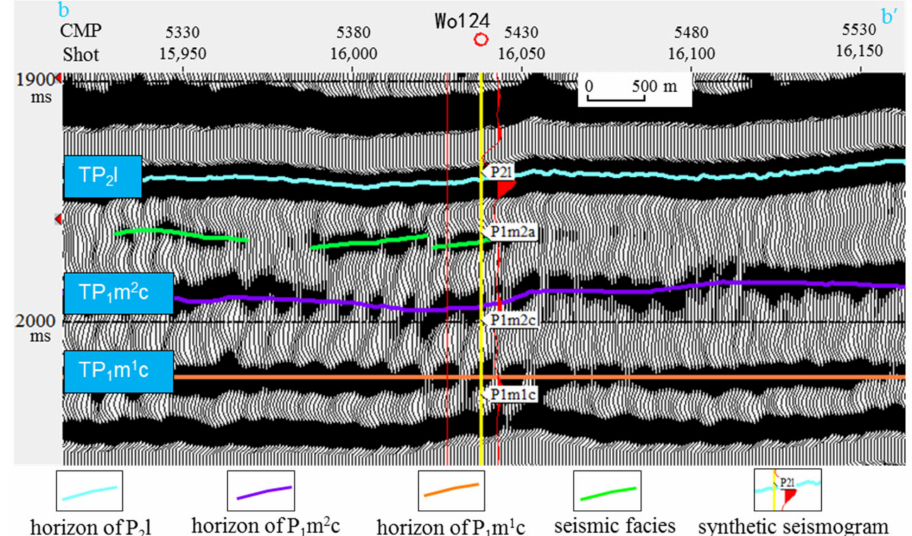
Figure 8. Seismic facies of imbricate progradation (seismic line through Well